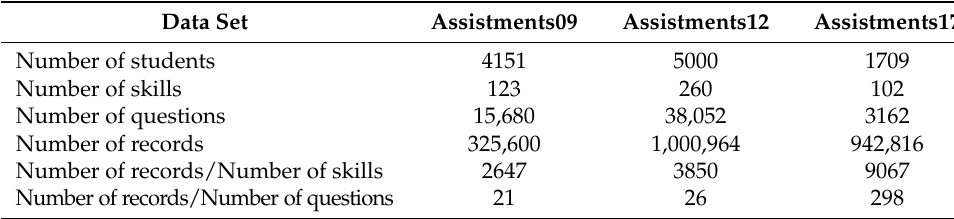
Table 4. Data set statistics.